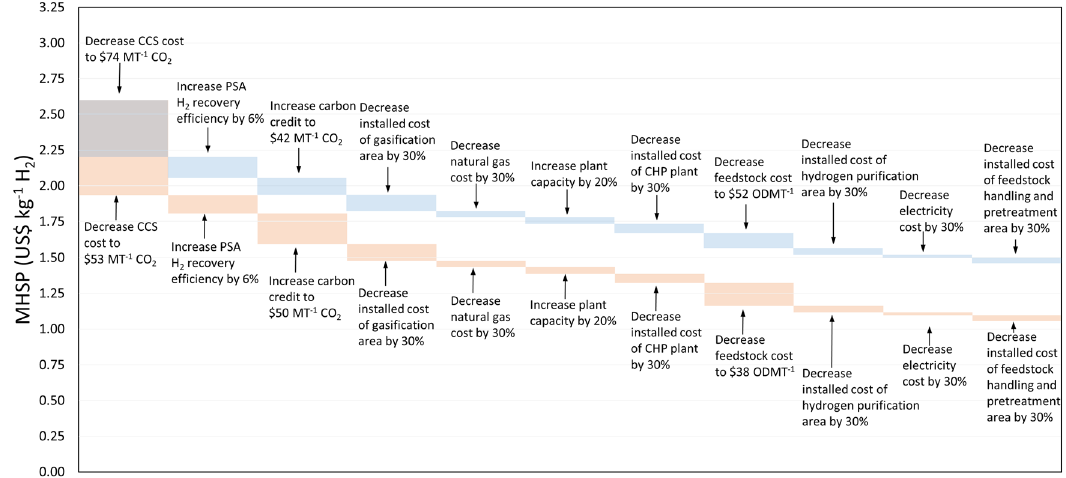
Fig. 5 Improvement analysis of Scenario 3-MPW at 2000 oven-dry metric tons per day under two pathways. The shaded box areas in each pathway display the cost reduction potential of improving each parameter. The gray area of the fi rst bar represents the overlaps between the fi rst and second pathways. Eleven parameters identi fi ed by the sensitivity analysis as the major drivers of economic feasibility were evaluated by their potential to be improved by current state-of-the-art practices (blue) or future advancement (orange). Detailed improvement measures for each parameter are provided in Supplementary Table 5. Detailed data of MHSP for each measure are in Supplementary Table